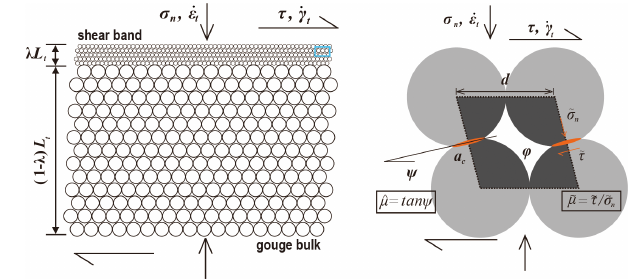
Figure 6. Gouge layer geometry assumed in the Chen–Niemeijer– Spiers (CNS) model. After Chen and Spiers